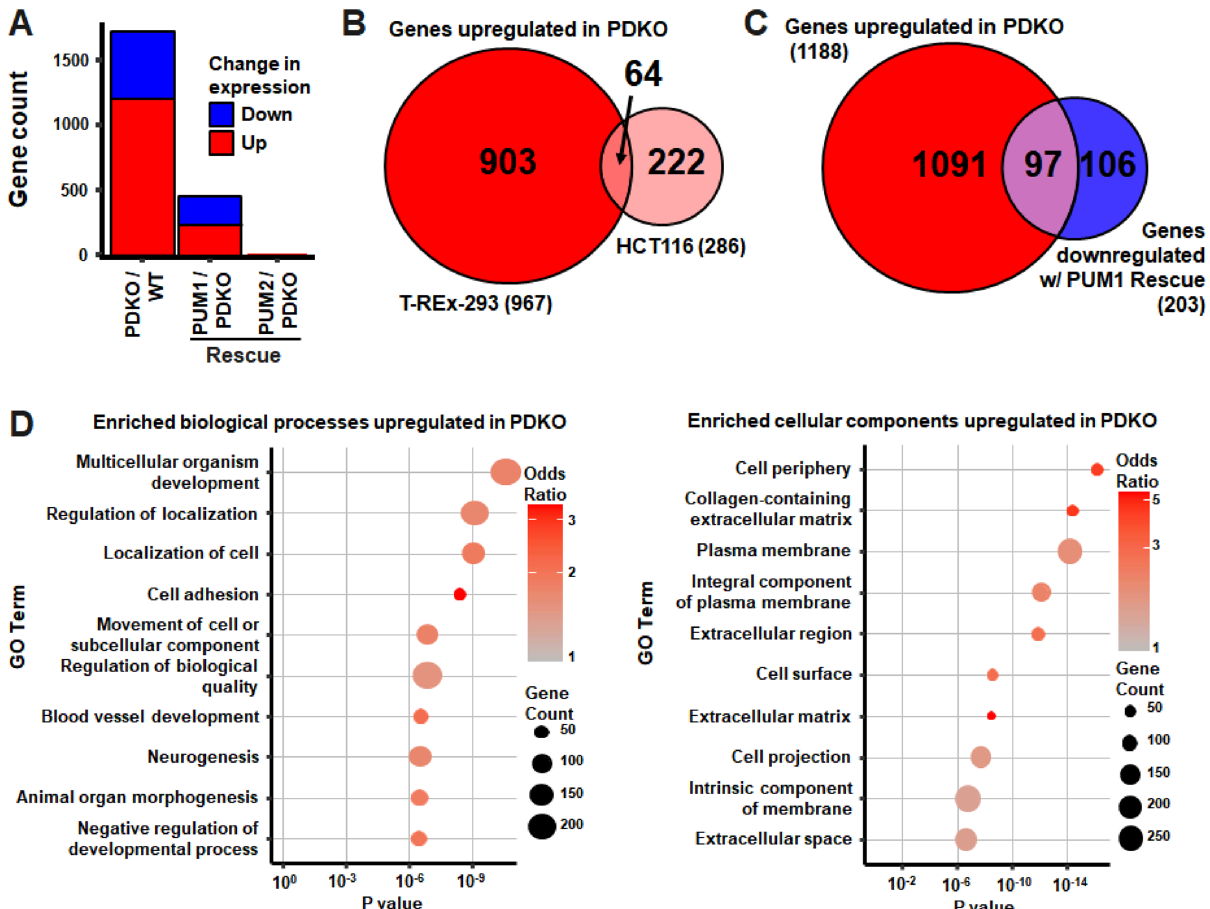
Figure 2. RNAseq analysis indicates that PUM proteins extensively regulate mRNA levels and control cell movement and adhesion processes. ( A ) Number of differentially expressed genes in T-REx-293 PDKO vs WT, and PUM1 or PUM2 rescue vs PDKO comparisons. ( B ) Overlap among genes upregulated in T-REx-293 and HCT116 PDKO cells. Only genes expressed and measured in both cell lines were used in the analysis. ( C ) Overlap of genes upregulated in T-REx-293 PDKO vs WT with genes downregulated in PUM1 rescue vs PDKO. ( D ) Gene ontology (GO) biological process and cellular component terms enriched in genes upregulated in PDKO vs WT